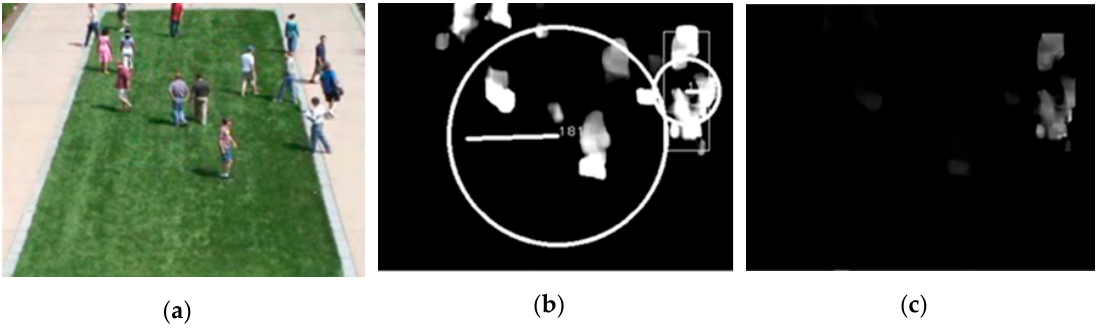
Figure 6. Example result of calculating R grad . ( a ) original frame; ( b ) F grad ; ( c ) R grad.